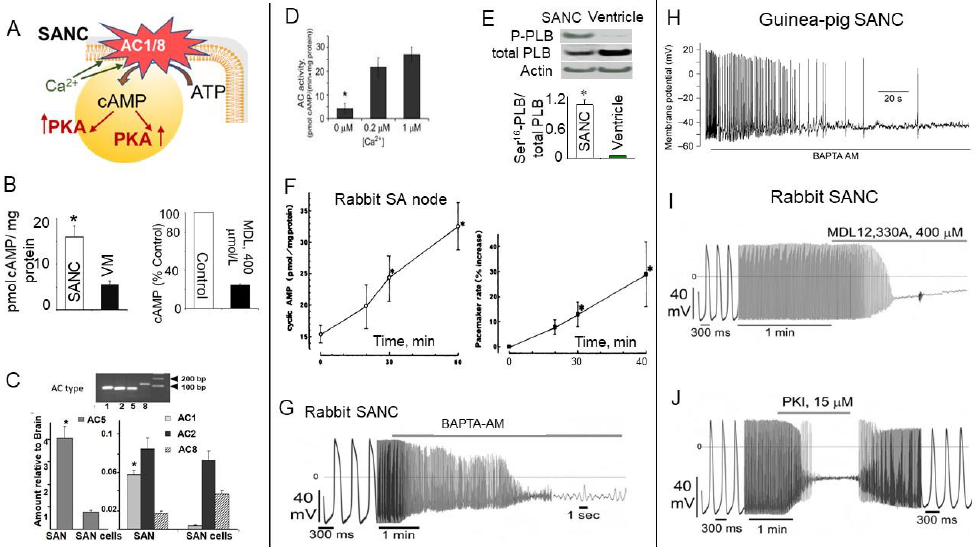
Figure 2. Constitutive AC activation, high basal level of cAMP, and PKA-dependent protein phosphorylation is central for spontaneous firing of cardiac pacemaker cells. ( A ) Cartoon representing constitutive activation of ACs, high basal level of cAMP, and PKA-dependent phosphorylation in SANC. ( B ) Left, average basal cAMP in SANCs or ventricular myocytes (modified from [41]); right, AC inhibitor MDL-12,330A markedly decreases cAMP in SANC (modified from [40]). ( C ) Abundance of AC isoform transcripts in the rabbit SA node or SANC relative to brain tissues (from [42]). ( D ) Presence of Ca 2+ -stimulated AC activity in whole cell lysates of intact rabbit SANC (from [42]). ( E ) Basal level of PLB phosphorylation at PKA-dependent Ser 16 site is significantly higher in SANC compared to ventricular myocytes (VM) (modified from [40]). ( F ) Time course of the effect of AC activation by cholera enterotoxin on cyclic AMP content (left) and pacemaker rate (right) of the rabbit SA node preparation (with permission, from [43]). ( G – J ) Ca 2+ chelation, AC or PKA inhibition suppresses spontaneous SANC beating rate; representative examples of: ( G ) effects of Ca 2+ chelation by 25 µ mol/L BAPTA-AM in rabbit SANC (from [42]) and (H) 10 µ mol/L BAPTA-AM in guinea pig SANC (with permission from [44]); ( I ) effects of AC inhibition by MDL-12,330A (400 µ mol/L) and ( J ) PKA inhibition by specific PKA inhibitory peptide PKI (15 µ mol/L) ( I – J from